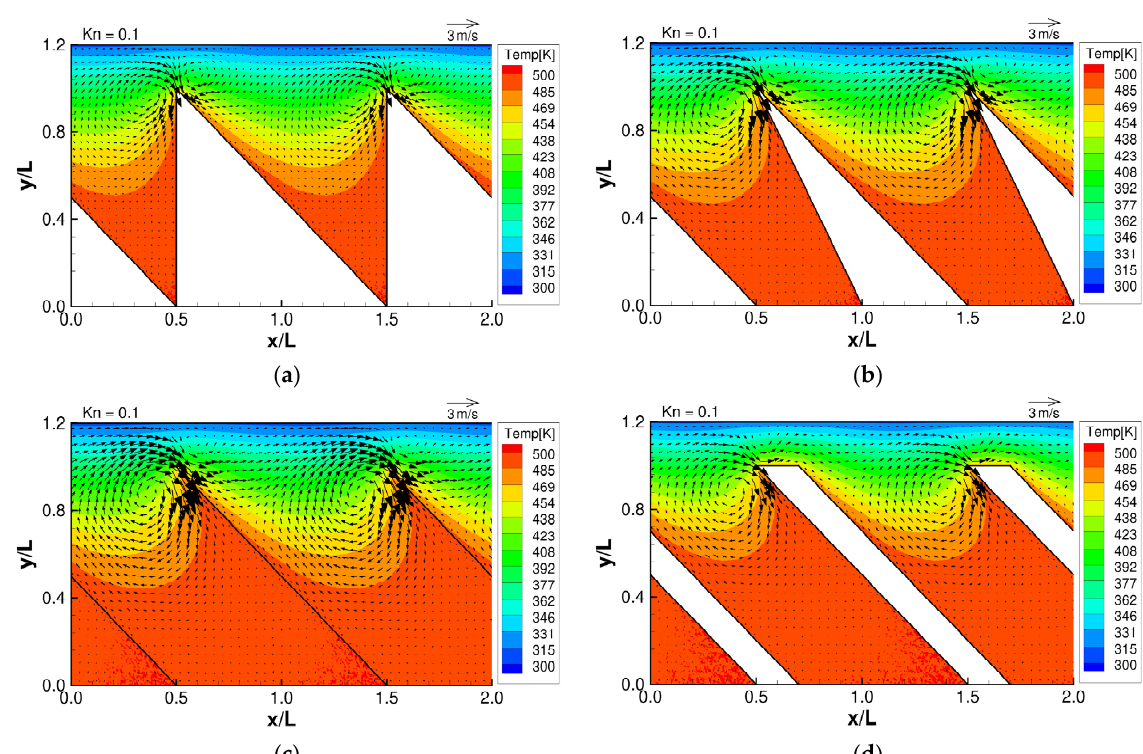
Figure 2. Computational domain used in each microstructure.